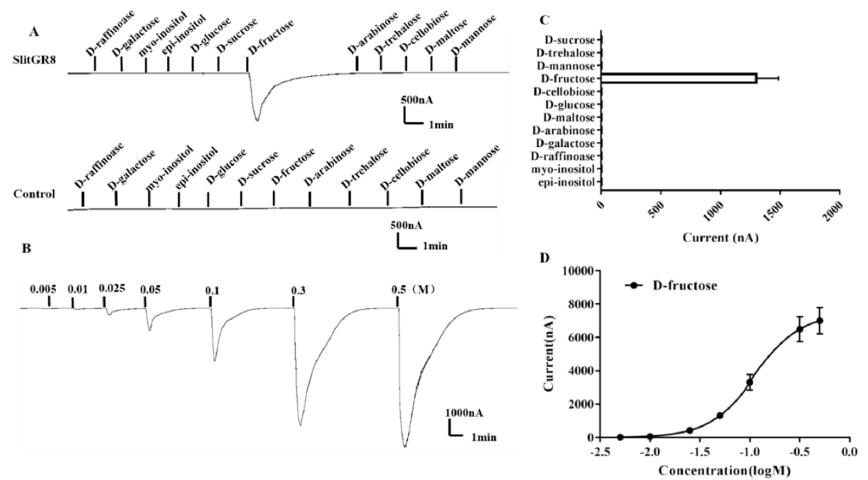
Figure 4. Responses of Xenopus oocytes expressed with SlitGR8 to stimulation of sugar components. ( A ) Inward currents of Xenopus oocytes injected with SlitGR8 cRNA (upper) and buffer (lower) to sugar components (0.1 M). ( B ) Response profile of Xenopus oocytes expressed with SlitGR8 . Error bars indicate SEM (n = 5). ( C ) Response of SlitGR8 expressing Xenopus oocytes to D-fructose of different concentrations. ( D ) Dose–response curve of SlitGR8 expressing Xenopus oocytes to D-fructose, with EC 50 = 0.217 M. Error bars indicate SEM (n = 5).